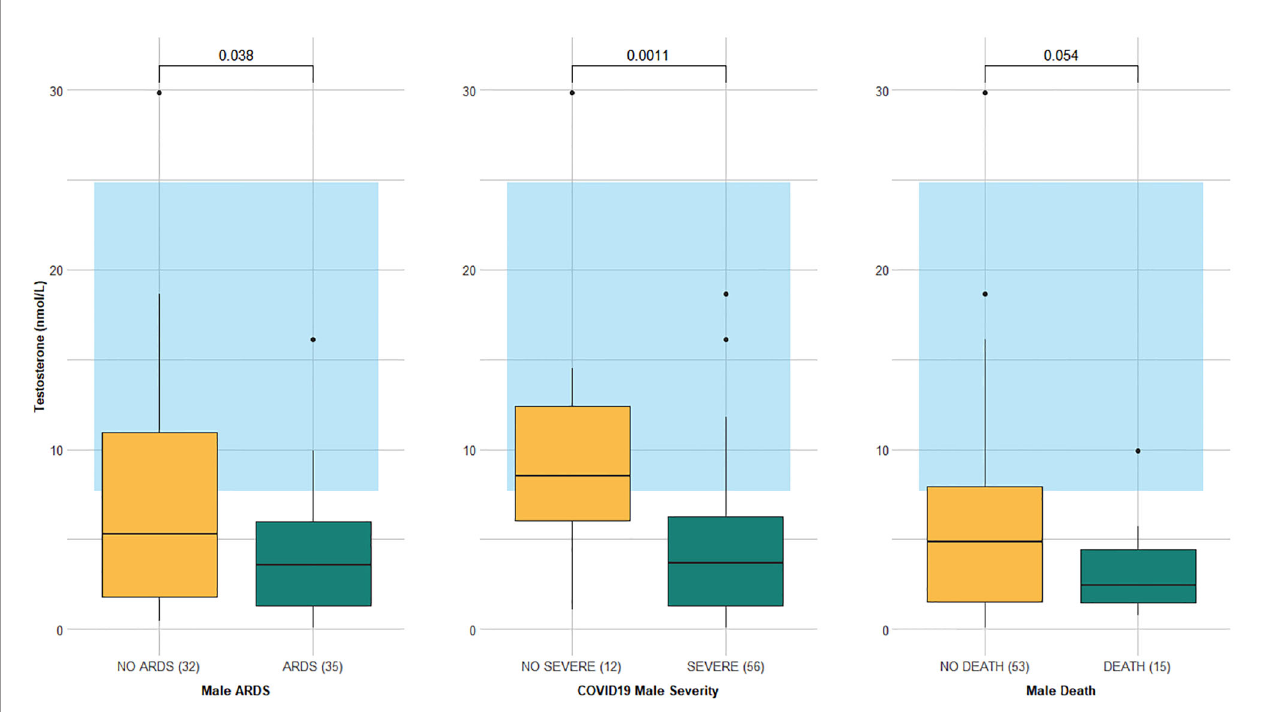
FIGURE 2 | Testosterone levels according to outcomes (ARDS, severe COVID-19, and in-hospital mortality) in 68 males aged 50 years and older. Data are expressed as box plot with median (cross line) and interquartile ranges; whiskers are the minimum and maximum values. The laboratory-assessed hormone reference ranges are indicated in light blue. Circles represent the outliers.